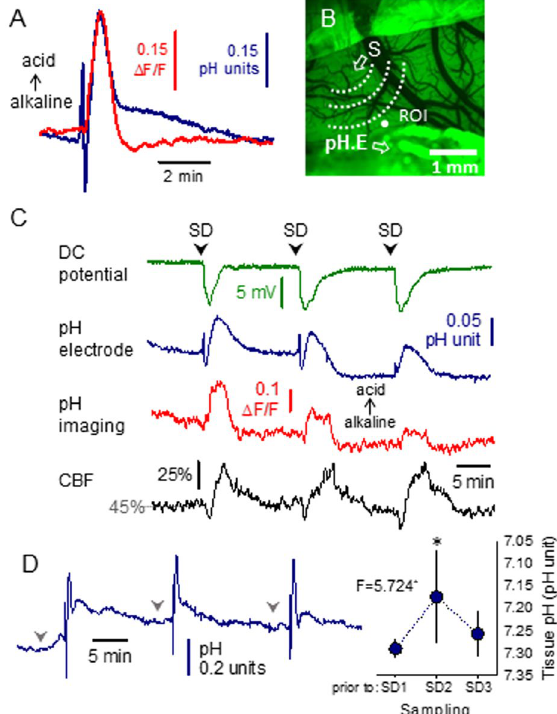
Figure 2. Changes in Neutral Red (NR) fluorescence indicate tissue pH variations with spreading depolarization (SD) and correlate with the signature of SD acquired with pH-sensitive microelectrodes. ( A ) Overlay of traces recorded with pH-sensitive microelectrodes (blue) and imaging of NR fluorescence (red), taken during the propagation of recurrent SD waves in the intact cortex of young rats. Note that acidosis (decreasing pH) is depicted upward. Each trace is the mean of individual events (SD2) obtained from separate experiments (n = 6). ( B ) A field of view revealed by the cranial window at green light illumination. A region of interest (ROI) indicates the origin of NR and cerebral blood flow (CBF) traces shown in panel C. Note the tip of the capillary used to trigger SD (S), and the position of the pH sensitive and reference electrodes (pH.E) inserted into the cortex to acquire local changes in tissue pH and direct current (DC) potential. ( C ) Synchronous traces obtained during ischemia from the cranial window of a young rat shown in panel B. Note the good correspondence of pH signals acquired with a pH-sensitive microelectrode (blue) and NR imaging (red). The DC potential trace (green) confirms SD occurrence. ( D ) A representative trace of tissue pH variations acquired with a pH-sensitive microelectrode from the intact cortex of a young rat indicates that baseline tissue pH remains elevated after the first SD event, and returns to pre-SD1 level gradually. Mean values of tissue pH at the time points indicated by gray arrow heads above the representative trace are shown in the plot to the right. Data are given as mean ± stdev. Statistical analysis relied on a repeated measures ANOVA paradigm (F value is given in the plot, level of significance was determined as * p < 0.05) followed by pairwise comparisons ( * p < 0.05 vs. prior to